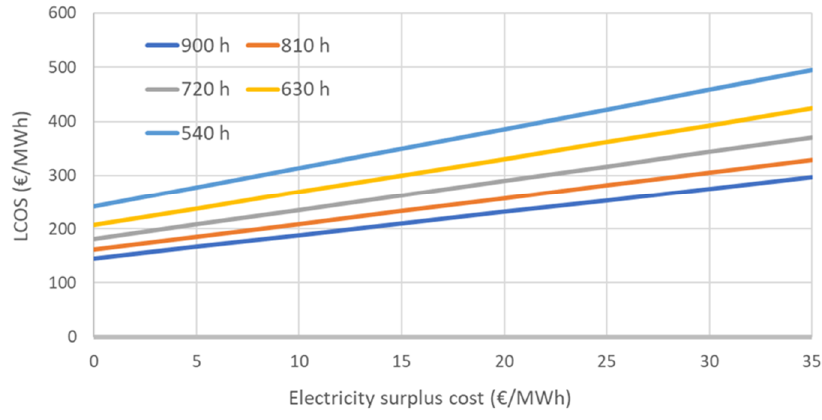
Figure 9. Levelized cost of storage (LCOS) of PtG vs. electricity surplus cost for various utilization